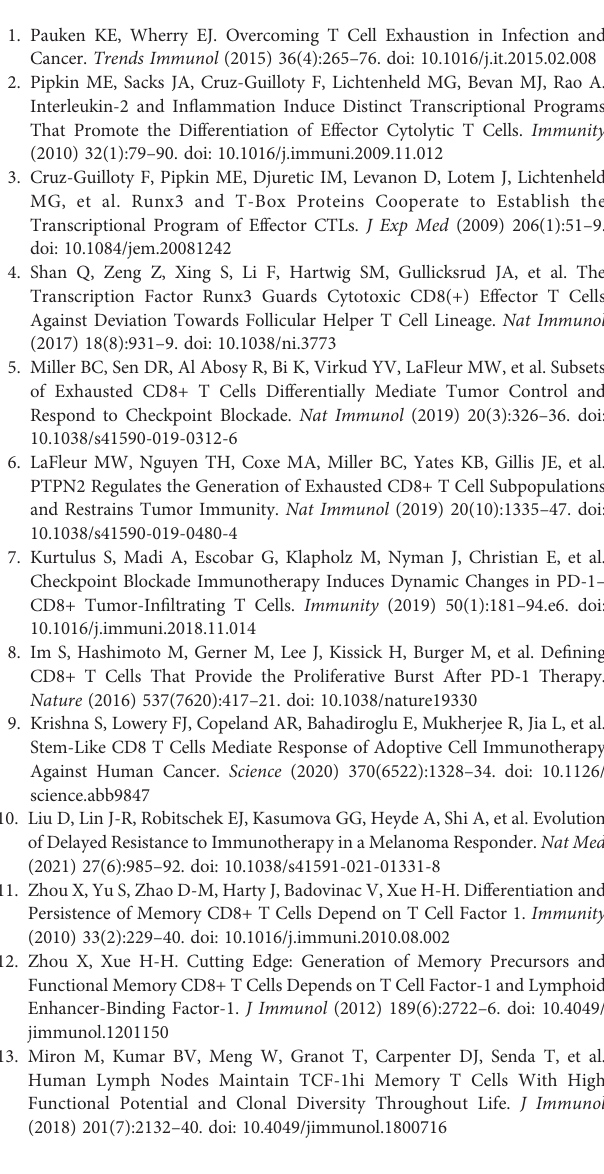
Supplementary Figure 8 | Analysis of CD8+ progenitor and terminally exhausted T cells. (A) Frequencies of progenitor exhausted (TIM3+CXCR5+) and terminally exhausted (TIM3+CXCR5 – ) CD8+ T cells in all tumors from Cbx3 fl / fl Lef1 fl / fl ( Cbx3 - Lef1 -de fi cient), Cbx3 fl / fl ( Cbx3 /HP1 g -de fi cient) and control (CD8 a -Cre or wt) mice were assessed; n = 3-5; representative of 2 experiments. (B) Progenitor exhausted (TIM3+CXCR5+) and terminally exhausted (TIM3+CXCR5 – ) CD8+ T cells were identi fi ed in tumors from B6.SJL mice treated with Cbx3 fl / fl Il21r-/- , Cbx3 fl / fl or control CD8+ effector T cells (CD45.2+); n = 3-5 recipients; representative of 2 experiments. Supplementary Figure 9 | Analysis of tumor in fi ltrating immune populations. (A) Frequencies of NK1.1+NKG2D+, CD4+NKG2D+ T, Gr1+ and Mac1+ myeloid cells in tumors from Cbx3 fl / fl Lef1 fl / fl ( Cbx3 - Lef1 -de fi cient) and control animals; representative of 2 experiments. (B) Frequencies of endogenous NK1.1+NKG2D+, CD4+NKG2D+ T, Gr1+ and Mac1+ myeloid cells in tumors from B6.SJL mice treated with Cbx3 fl / fl Il21r-/- and control CD8+ effector T cells; representative of 2